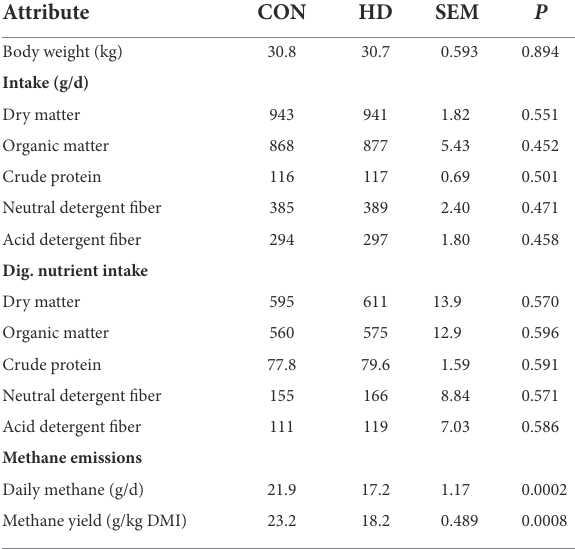
CON, control group (no Harit Dhara supplementation); HD, treatment group ( Harit Dhara supplementation @ 5% basal diet); DMI, dry matter intake; DDMI, digestible dry matter intake; DCP, digestible crude protein intake; DADF, digestible acid detergent fiber; DNDF, digestible neutral detergent fiber; CH 4, methane; SEM, standard error of mean. Mean values bearing different superscripts in a row differ significantly at 5%